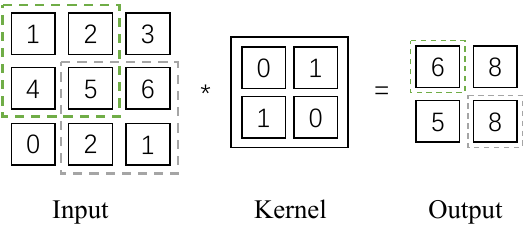
Figure 7. Convolution operation.